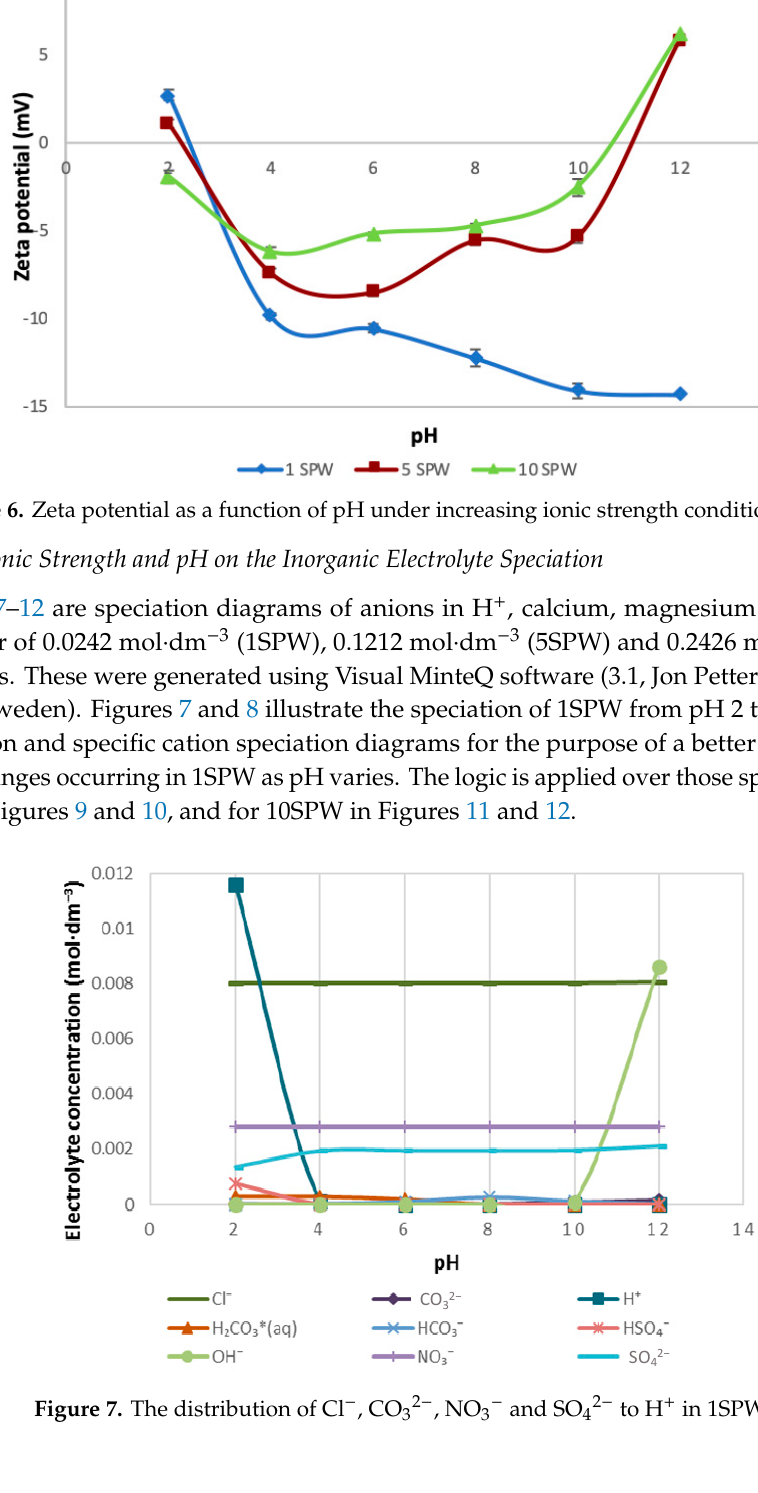
Figure 7. The distribution of Cl − , CO 32 − , NO 3 − and SO 42 − to H + in 1SPW.